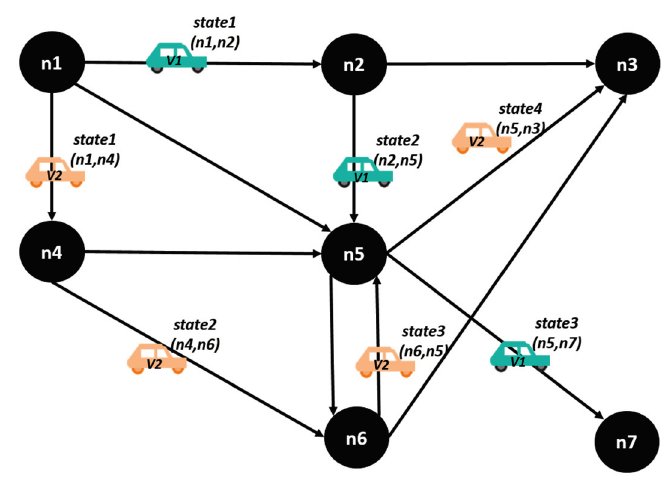
Figure 9. A vehicular network with four